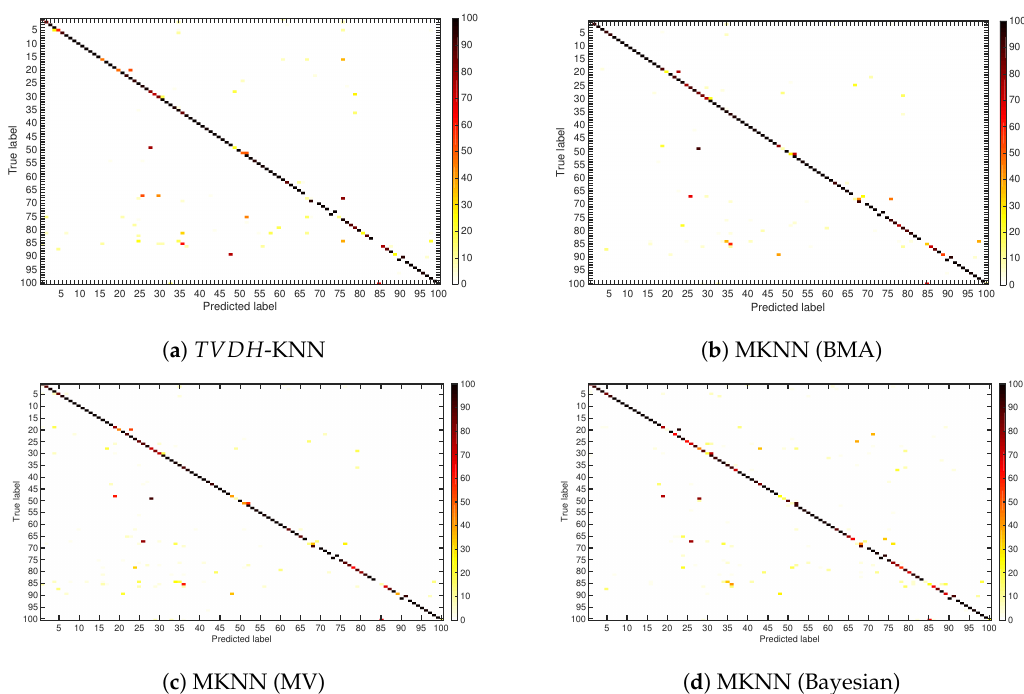
Figure 7. Confusion matrices of TVDH -KNN, MKNN (BMA), MKNN (MV) and MKNN (Bayesian).